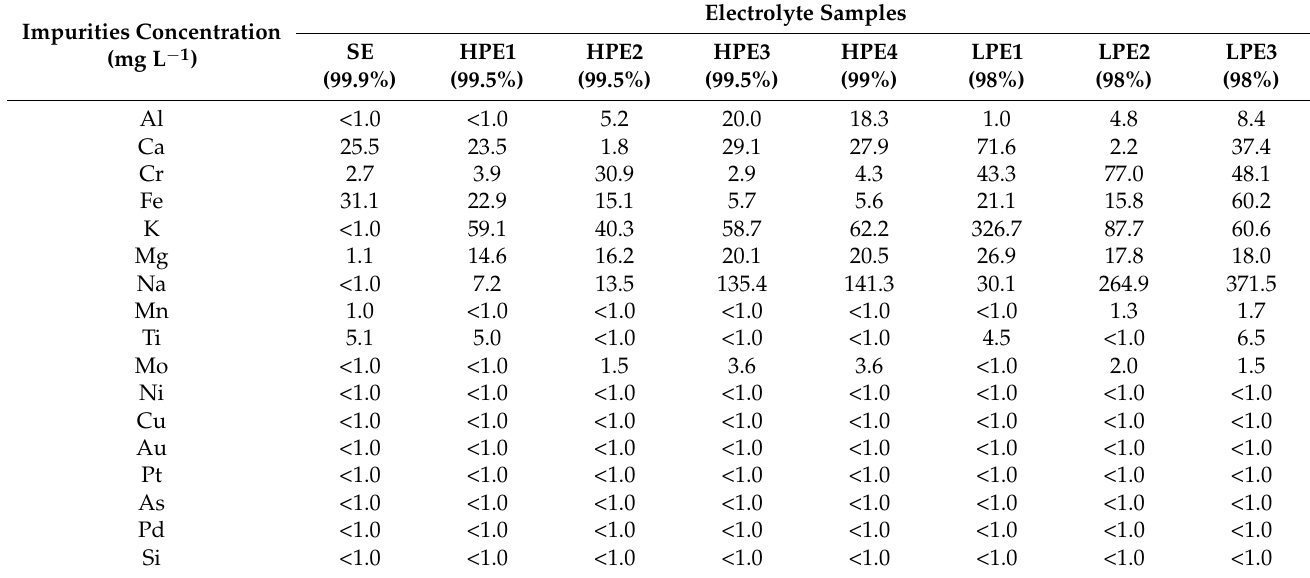
Table 2. The chemical composition of electrolytes prepared with different grades of V 2 O 5 raw material. Impurities